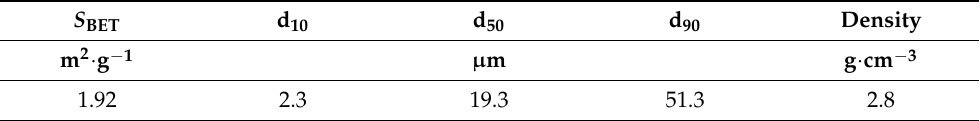
Table 4. Physical properties of dolomite sample. S BET —specific surface area; d 10,50,90 —deciles of size